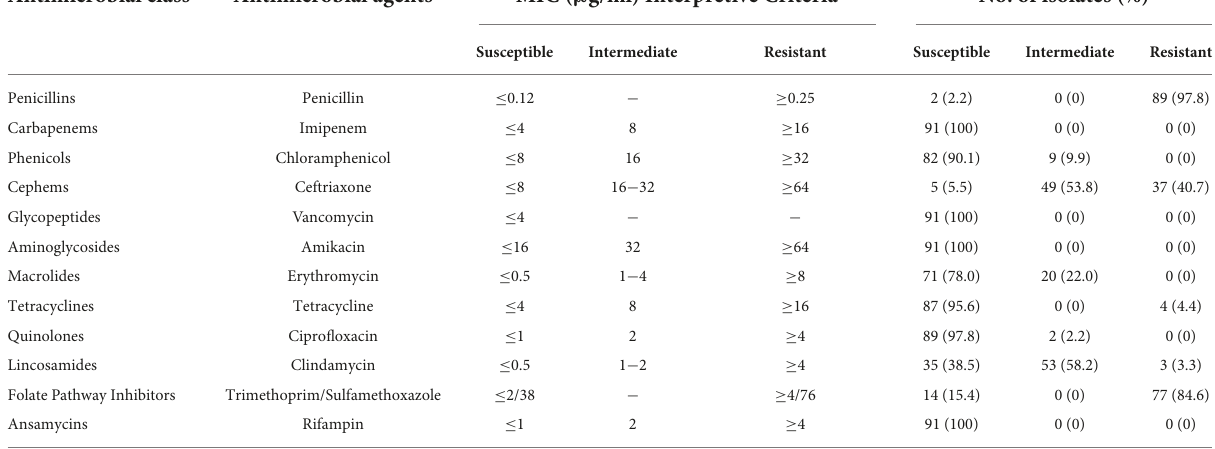
TABLE 3 Antibiotic susceptibility of Bacillus cereus isolates. Antimicrobial class Antimicrobial agents MIC ( µ g/ml) Interpretive Criteria No. of isolates (%)